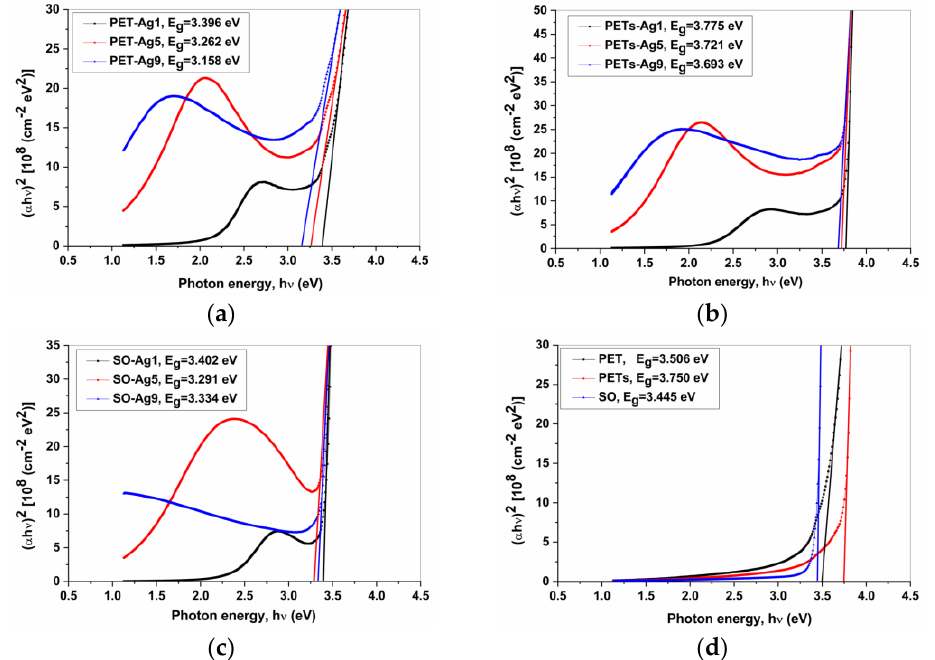
Figure 4. The bandgap graphical determination for ( a ) PET-Ag samples; ( b ) PETs-Ag samples; ( c ) SO-Ag samples; ( d ) substrates.